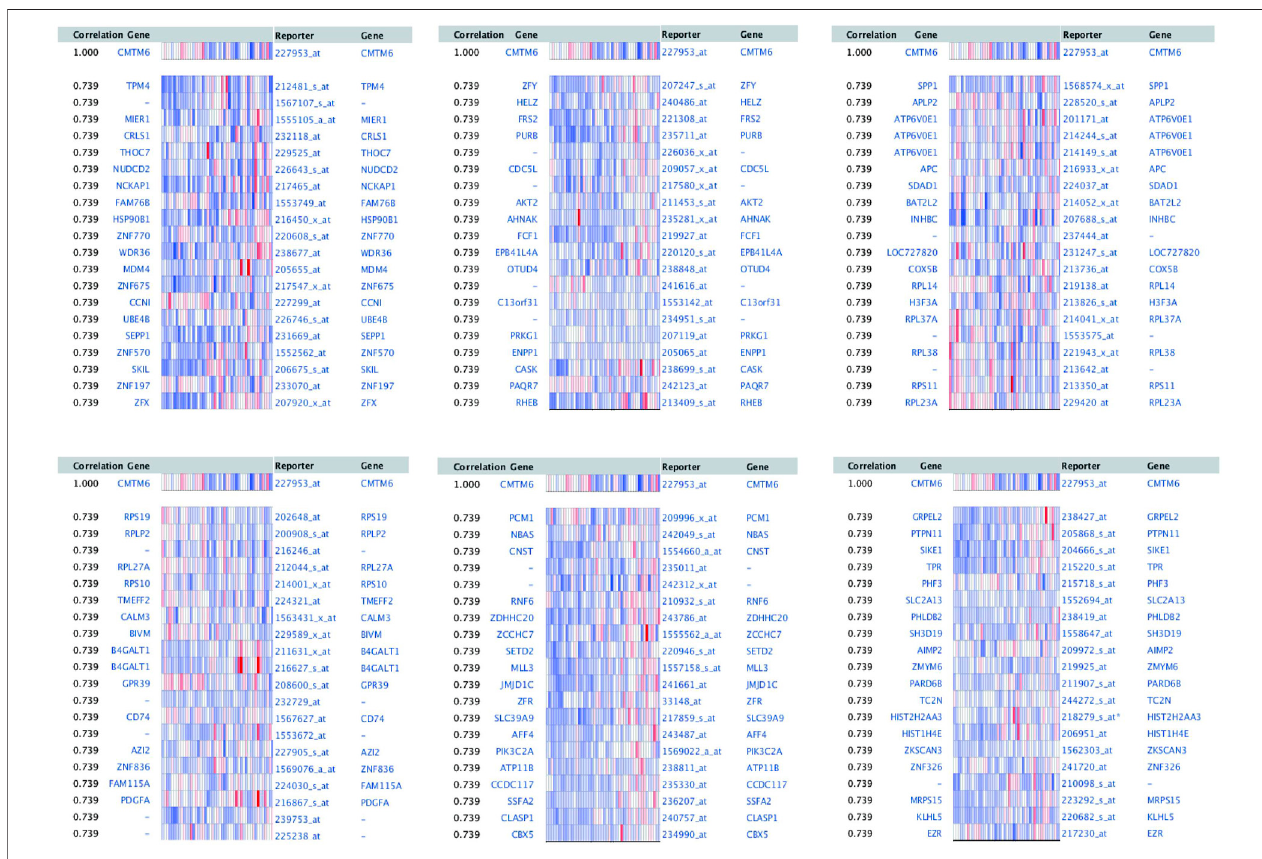
FIGURE 5 | First 100 genes coexpressed with CMTM6 in OV were screened from Tothill Ovarian in the Oncomine database.